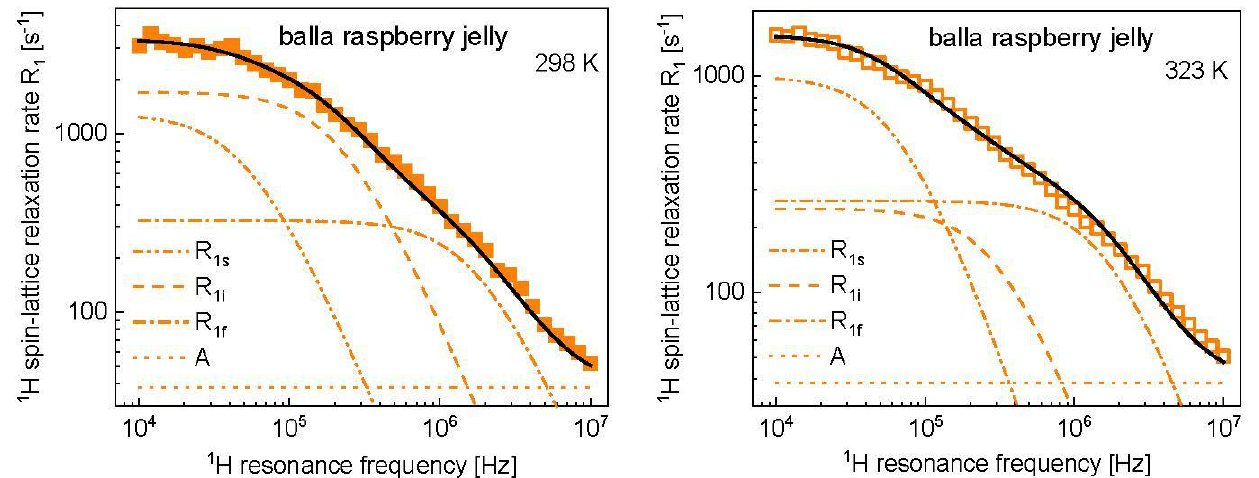
Figure 4. 1 H spin-lattice relaxation data for Haribo raspberry jelly at 298 K ( left ) and 323 K ( right ) reproduced in terms of the model described in the theory. The fit ( 𝑅 1 ) shown as a black solid line has